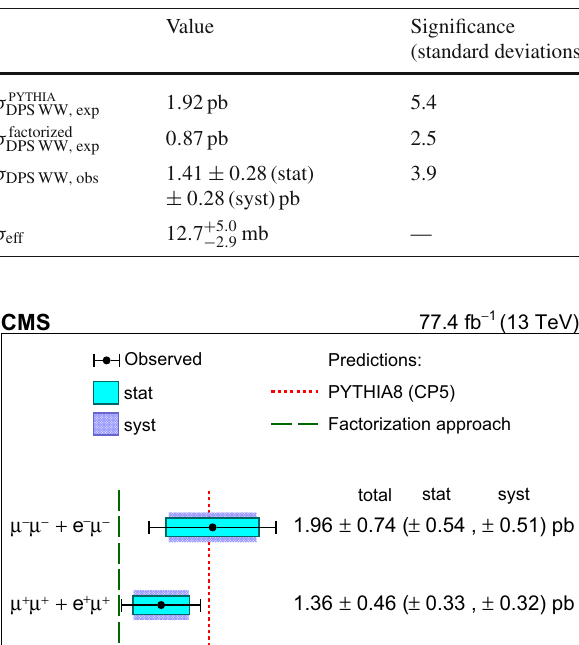
Table 3 Results obtained from the maximum likelihood fit to the final classifier distribution